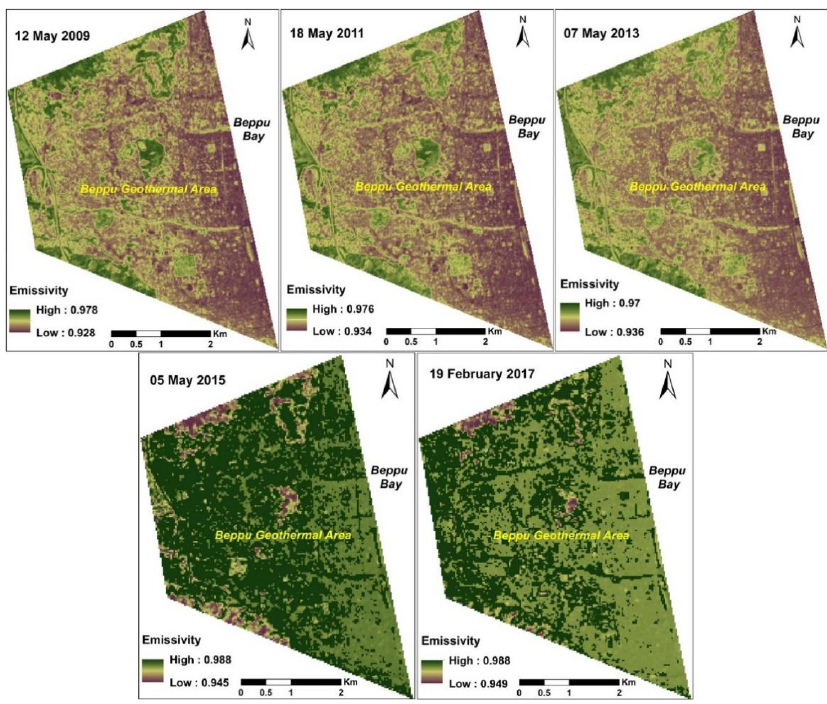
Figure 13. Average emissivity of the land cover of the Beppu geothermal area from 2009 to 2017.